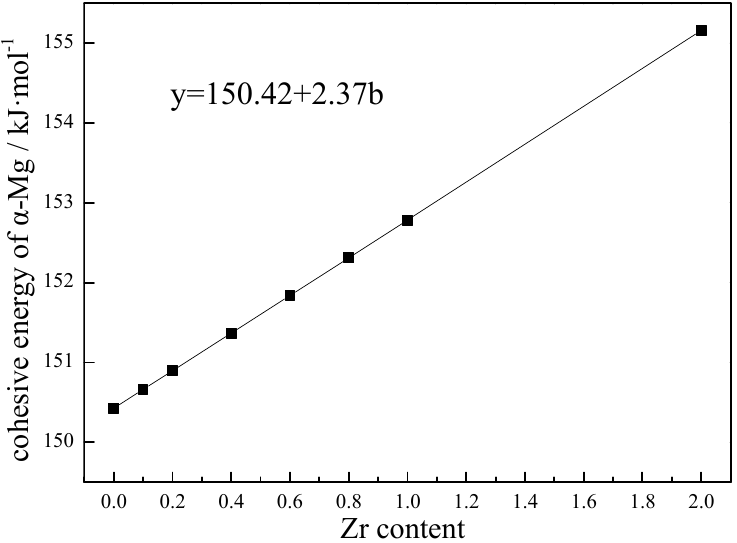
Figure 7. Cohesive energy of Mg with different Zr contents.